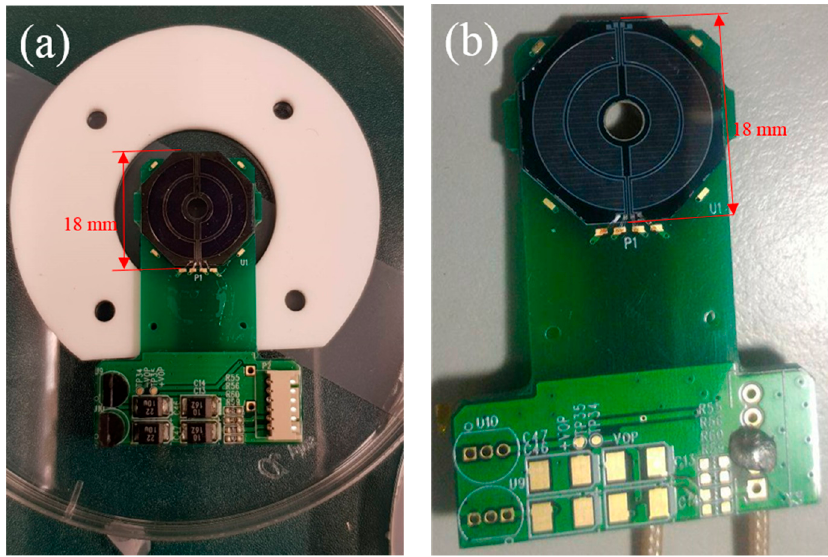
Figure 4. ( a ) The MA BSE detector with wire bonded on PCB. ( b ) The MA-Al BSE detector after wire bonded on PCB. bonded on